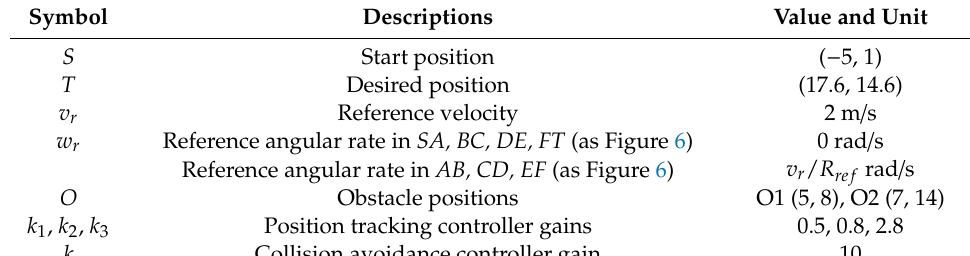
Table 3. Parameters of the second example simulation.